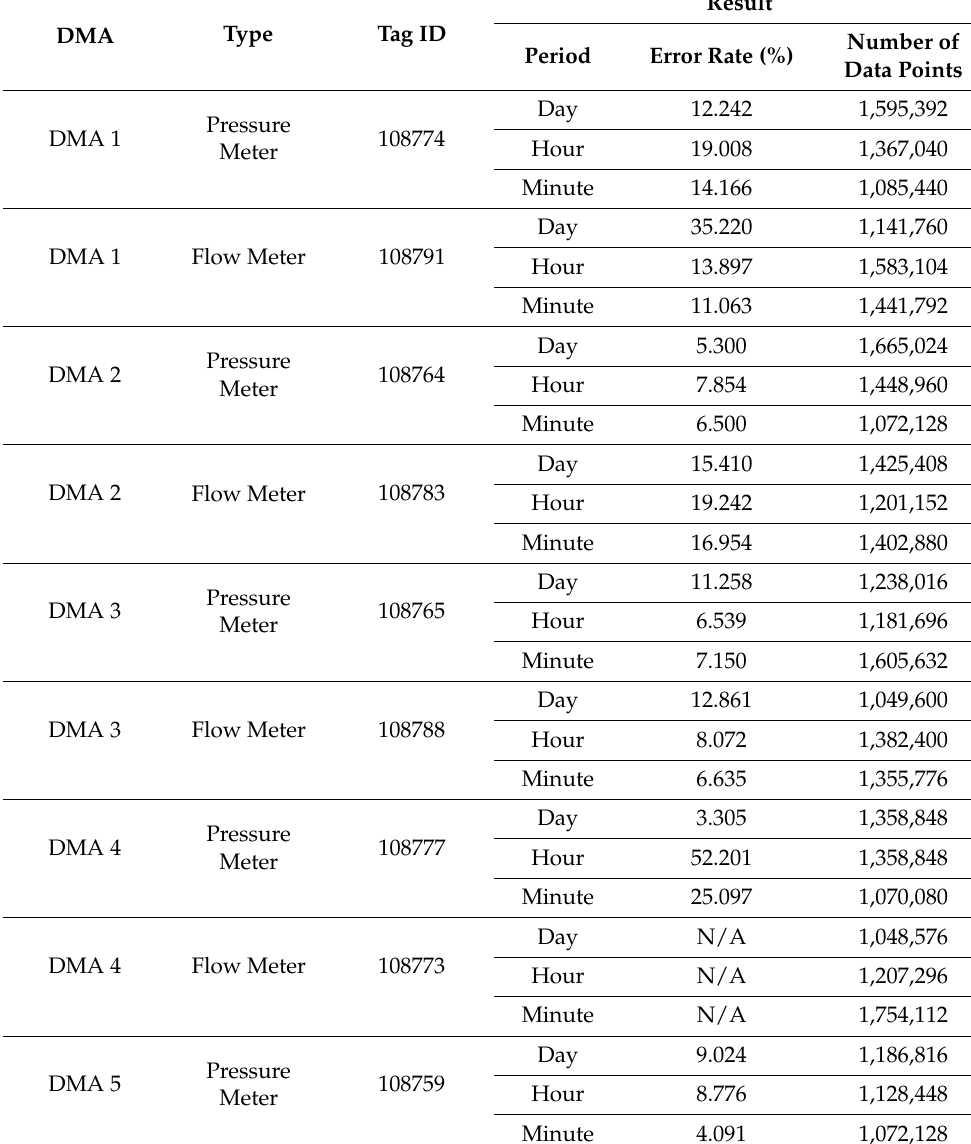
Table 3. AI prediction results with and without data preprocessing and validation.